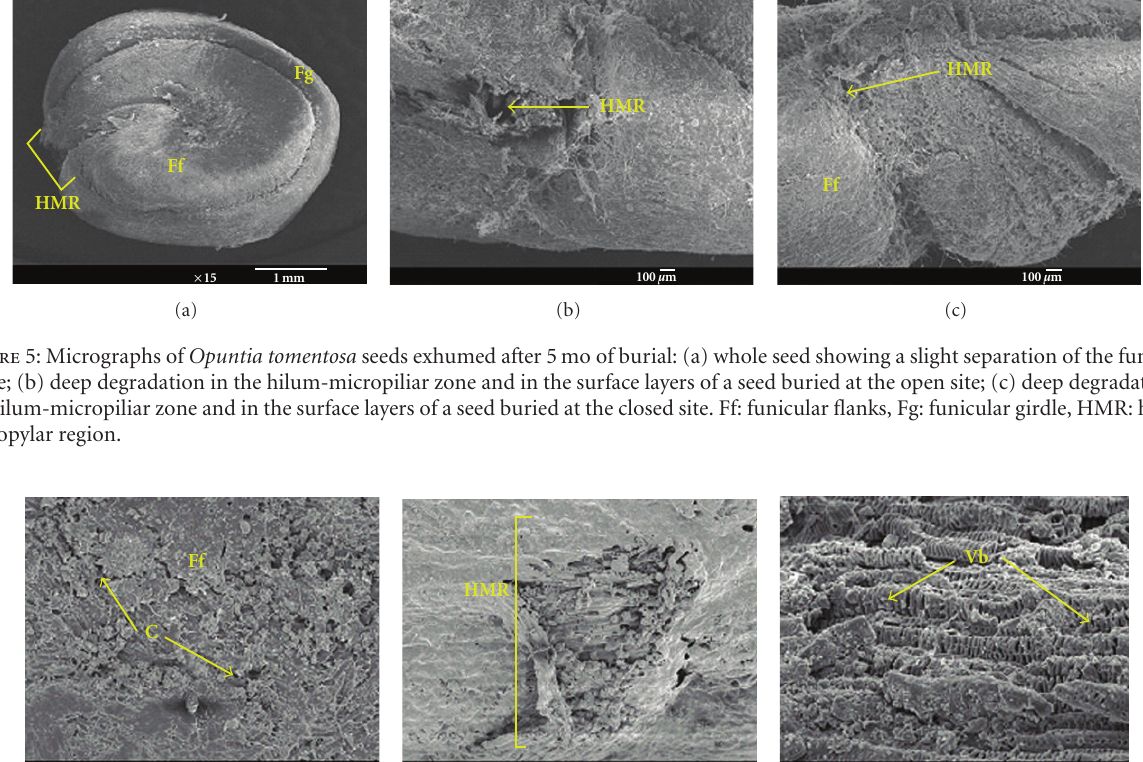
Temperature alone did not a ff ect the lag time ( F (1,35) =